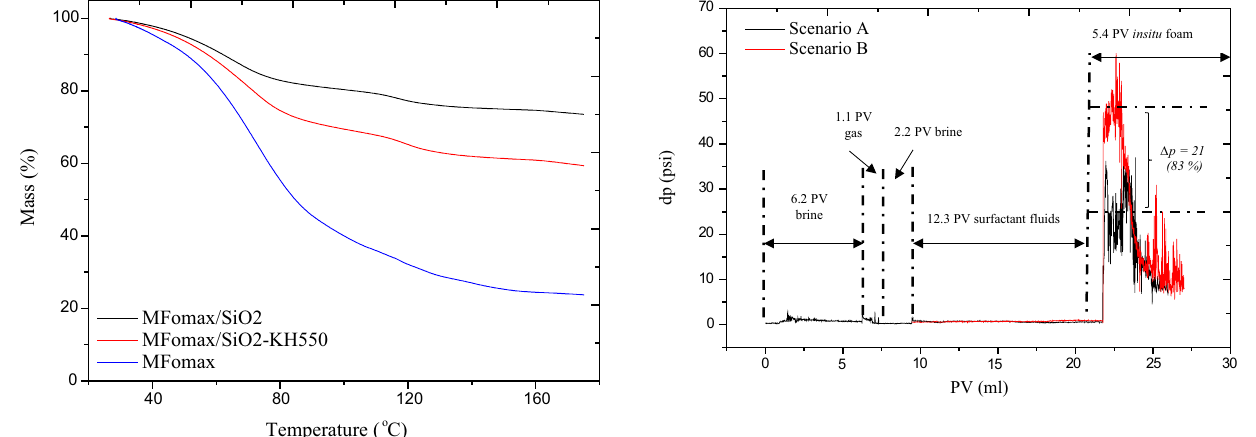
Fig. 13 The ∆ p buildup behavior in the core due to slugs of injection: at 110 °C and 2023